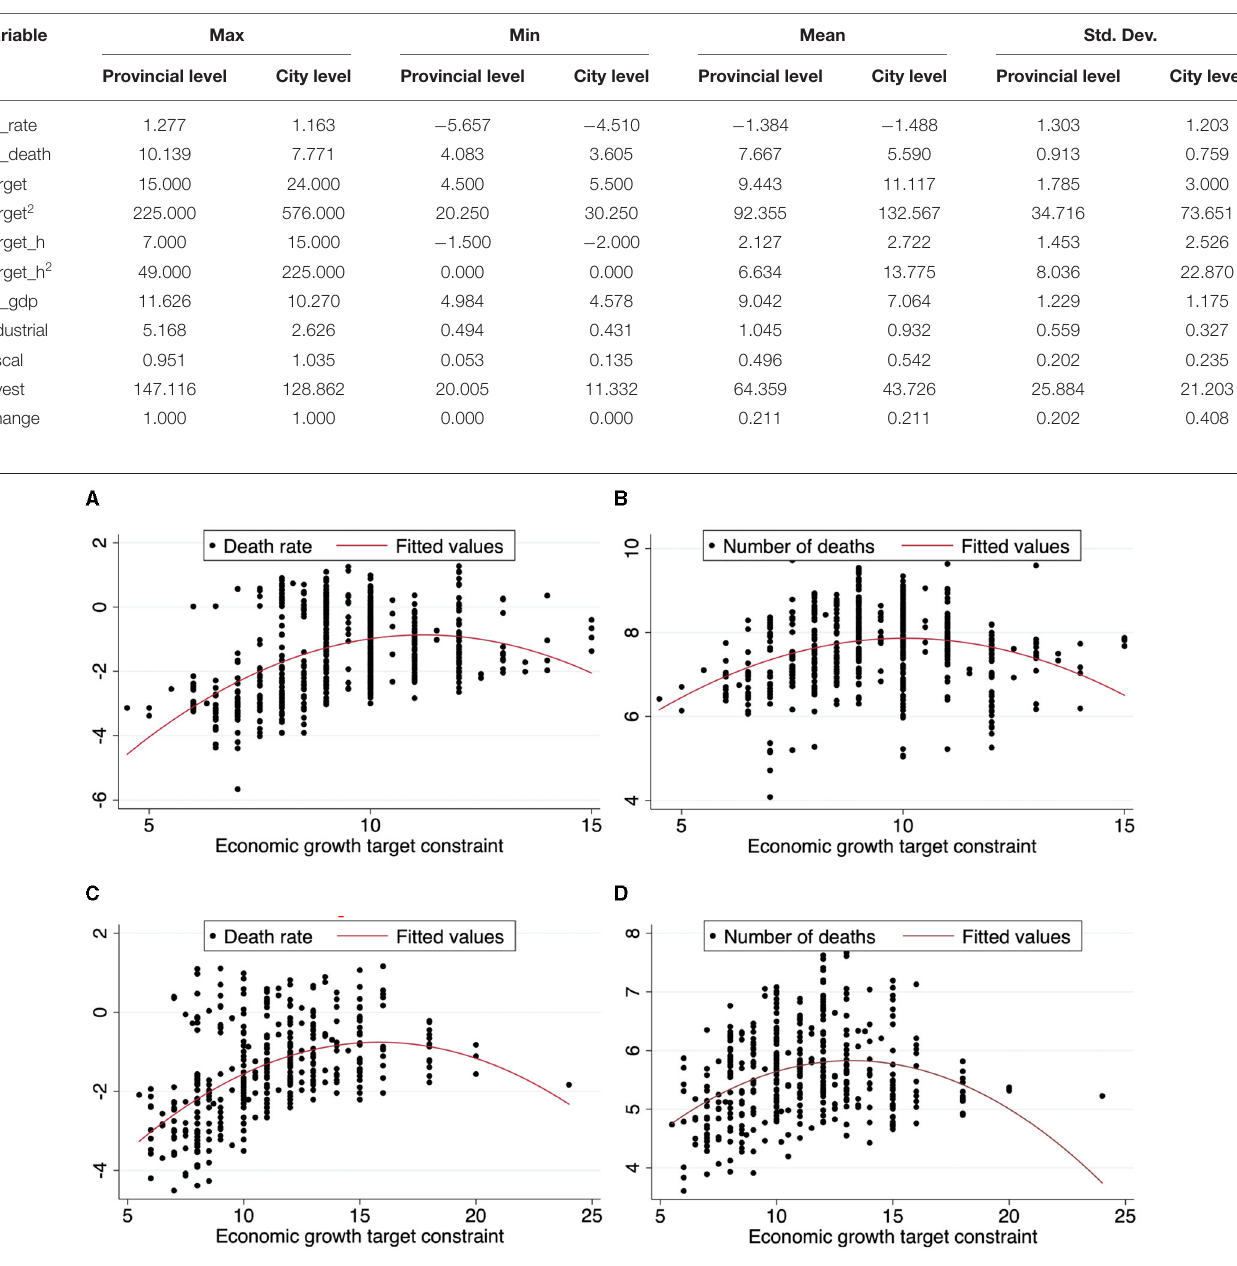
TABLE 1 | Descriptive statistics of the variables.